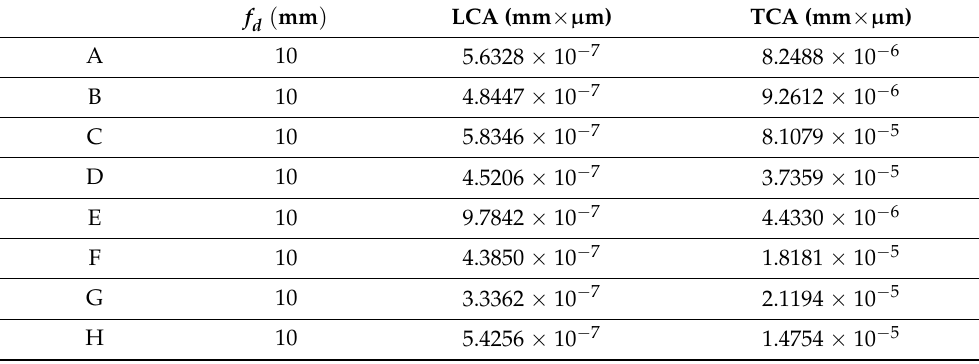
Table 3. Optimization results for the eight triplet lens groups selected by the illustration